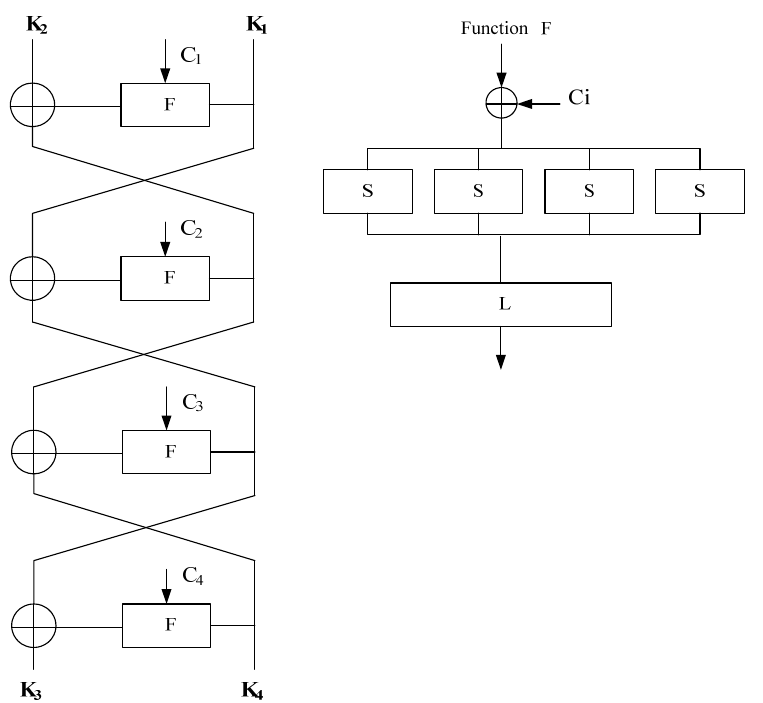
Figure 3. Round subkeys generation scheme.